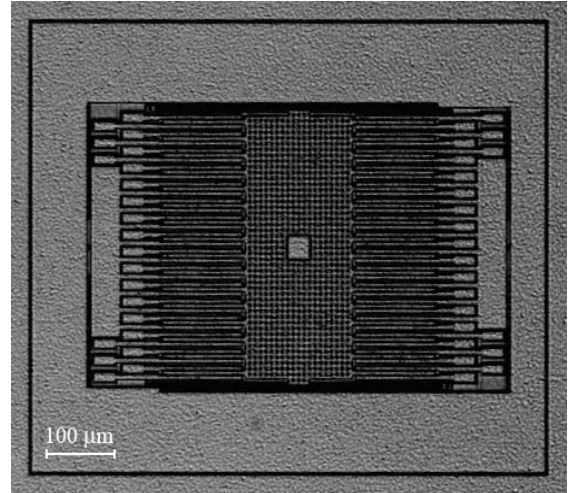
Figure 2. Fabricated MEMS